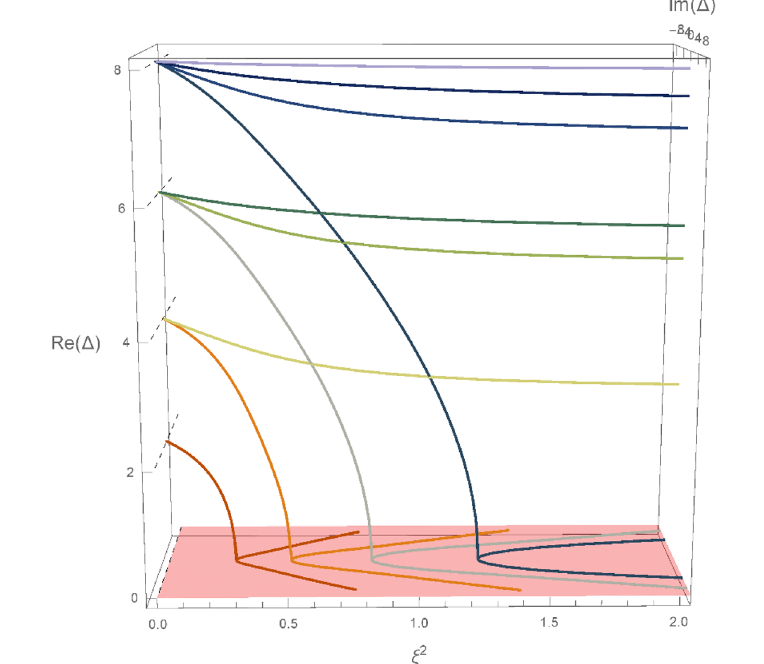
Figure 19 . The states with (cid:1)(0) = 2 ; 4 ; 6 ; 8 for J = 1 ; M = 1 with (cid:18) 1 = 5 = 6 and (cid:18) 2 = 1 = 6, S 1 = S 2 = 0. The number of states and weak coupling match precisely with the predictions obtained in section 5. Among the states with a given (cid:1)(0), one level reaches a square-root branch point where (cid:1) = 0, and the scaling dimension splits into two imaginary levels after this point, with a classical scaling at strong coupling, (cid:1)( (cid:24) 2 ) (cid:24) (cid:6) i(cid:24) , (cid:24) ! 1 . The states that do not reach a branch point appear to stay real for all values of the coupling, and tend to constant values at strong